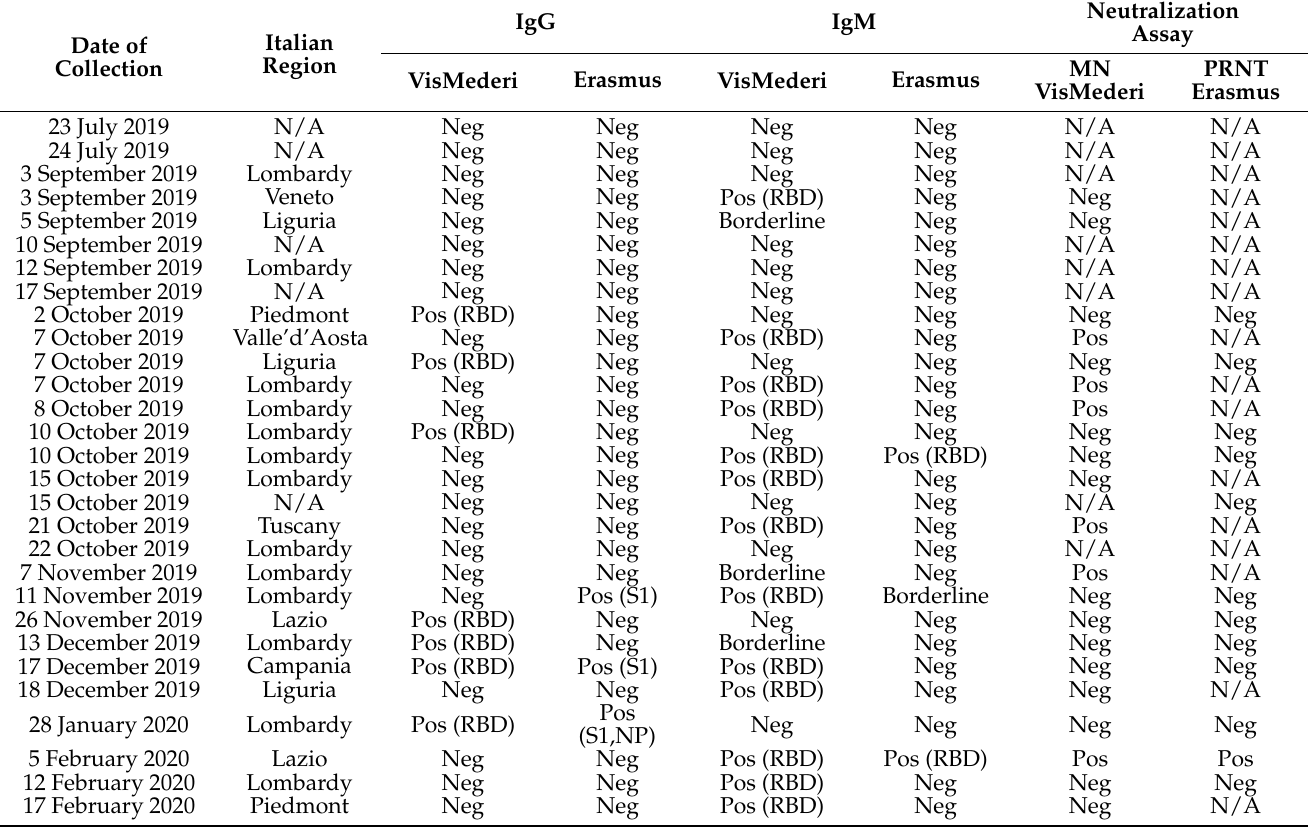
Table 1. Serological results of the SMILE series 2019–2020.